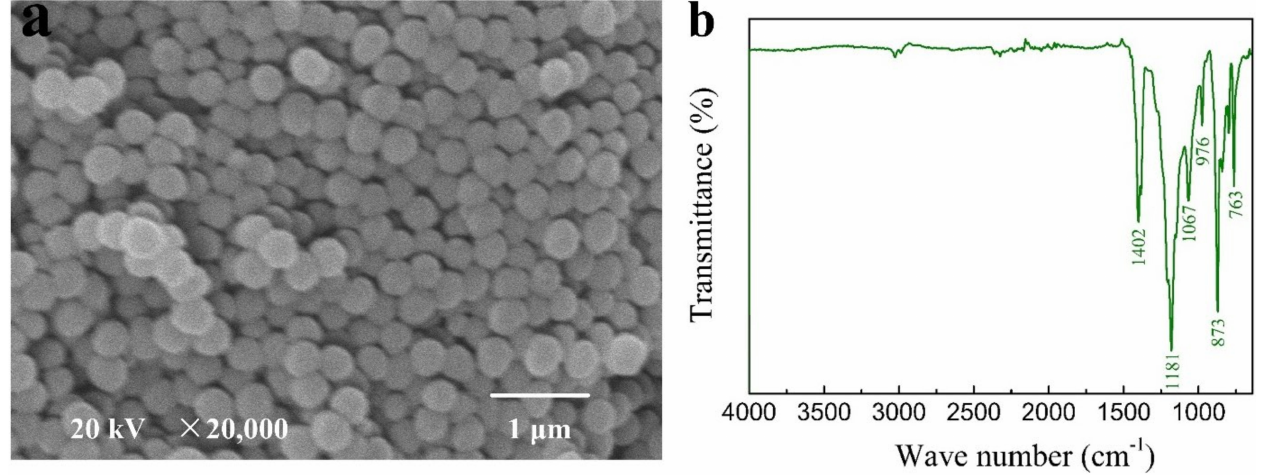
Figure 2. SEM image ( a ) and FTIR spectrum ( b ) of polyvinylidene fluoride